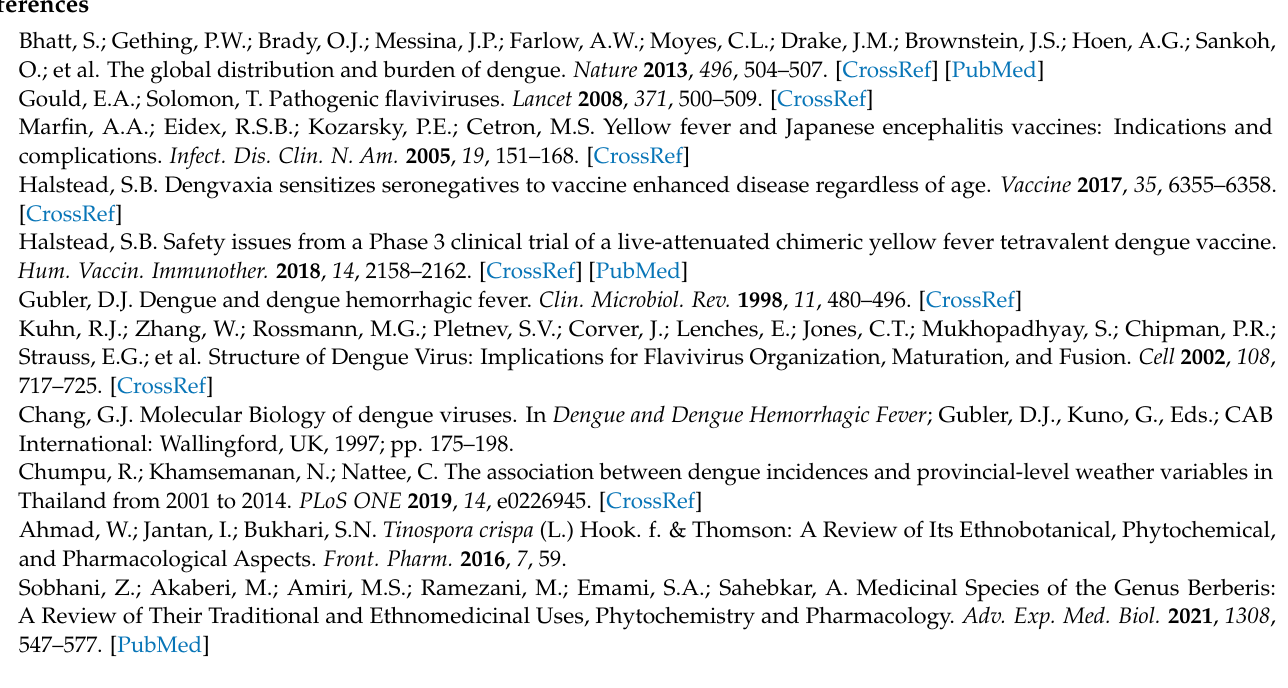
structure of berberine, Supplemental Figure S2. Cytotoxicity of BBR towards several cell lines, Supplement Figure S3. BHK-21 morphology after BBR treatment, Supplemental Figure S4. Opti- mization of DENV infection, Supplemental Figure S5. EC 50 calculation of BBR in DENV infection, Uncropped western